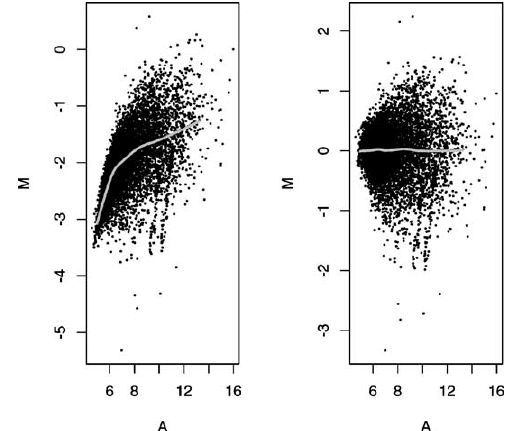
Fig. 3. M vs A plots for raw unadjusted data (on left) and after lowess normalization (right). The grey line seen in both pictures is the lowess line. The data are the same as in Fig. 2. Data courtesy Prof. A.B. Smit, Department of Molecular and Cellular Neurobiol- ogy, Vrije Universiteit, Amsterdam, The